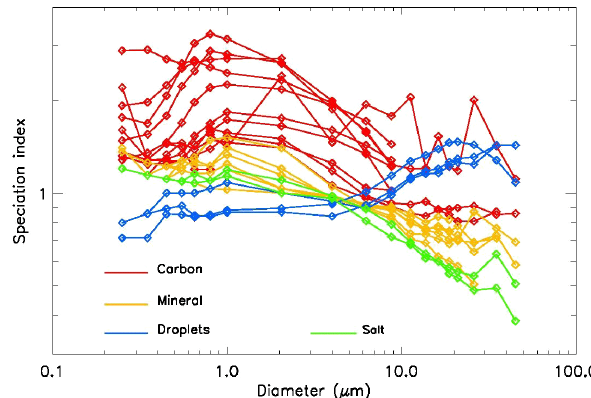
Figure 7. Evolution of the speciation index with diameters for var- ious families of samples; measurements were conducted in labora- tory with LOAC using pure